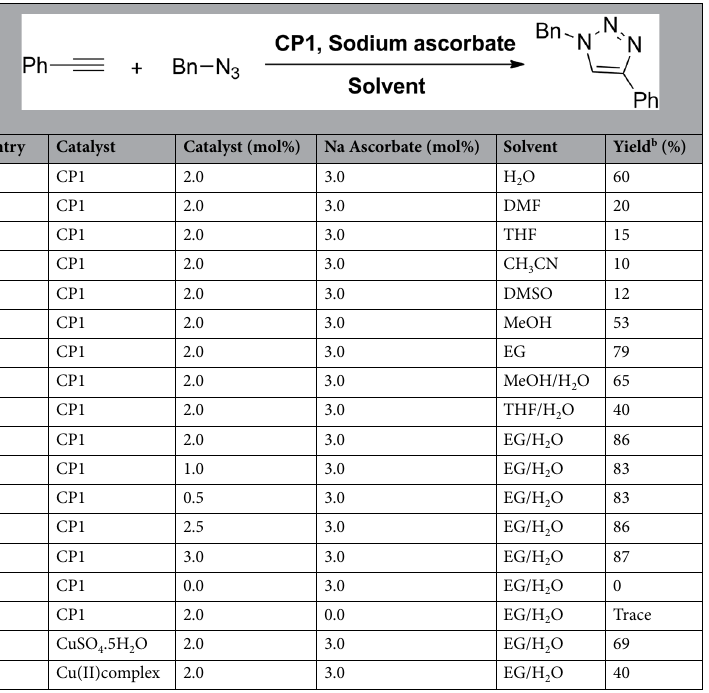
Table 1. Catalyst and Solvent optimization studies a . a Reaction conditions: phenylacetylene (0.6 mmol),